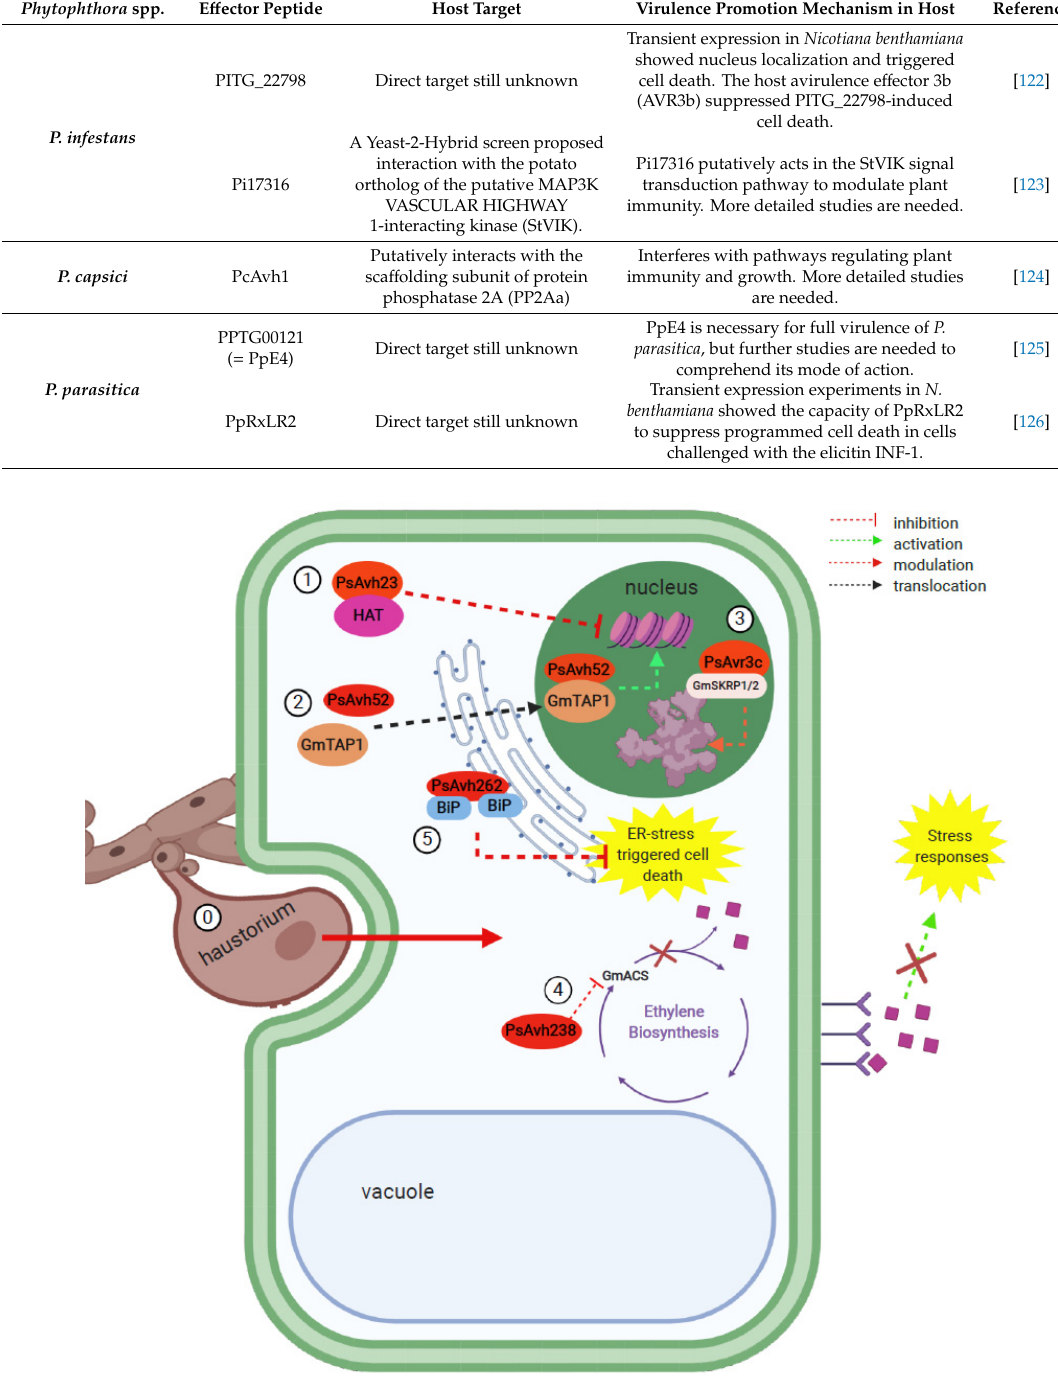
Figure 2. Representation of a selection of recently reported virulence peptides involved in the infection of plant cells by P. sojae . This figure shows a snapshot of the widespread metabolic changes induced by this oomycete as a result of the infection. (0) The haustorium penetrates soybean tissues and secretes effector peptides close to and into the plant cells [44]. (1) PsAvh23 binds to the regulatory subunit of the H3K9 histone acetyltransferase (HAT), preventing it from associating with the catalytic subunit and therefore, suppressing defense gene activation [15]. (2) PsAvh52 translocates the putative transacetylase protein GmTAP1 to the nucleus, leading to the acetylation of core histones and the upregulation of plant susceptibility genes [115]. (3) PsAvr3c stabilizes the spliceosome-associated protein GmSKRP1/2, causing changes in host pre-mRNA splicing, thus impairing plant immunity [117]. (4) PsAvh238 interacts with a type-2 aminocyclopropane-1-carboxylate synthase (GmACS), a key enzyme in ethylene biosynthesis, which disrupts ethylene signaling and therefore, impairs pathogen-induced stress responses in the plant host [120]. (5) PsAvh262 suppresses ER stress- triggered cell death by stabilizing luminal binding immunoglobulin proteins (BiPs), and therefore, promoting infection [121]. 6. Plant Antimicrobial Peptides 6.1. Introduction to Plant Antimicrobial Peptides The presence of small peptides in plant cells has been supported by increasing evidence from genomic, transcriptomic, and proteomic research studies [16,127–130]. The small peptides could be intragenic [127], encoded by genes consisting of one or two exons [16,128] or encoded by lncRNAs [130]. These small peptides play important roles in signaling and defense [131]. The small peptides with antimicrobial functions are termed antimicrobial peptides (AMPs) [132–134]. The structural features and functions of plant AMPs have been summarized in previous reviews [132–134]. Briefly,